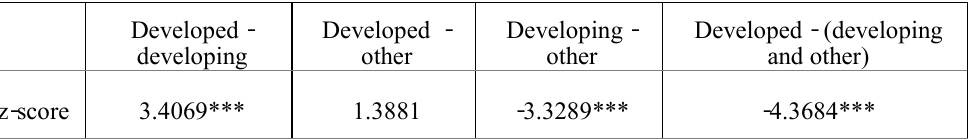
Table3. z-tests for difference in FDI average among country